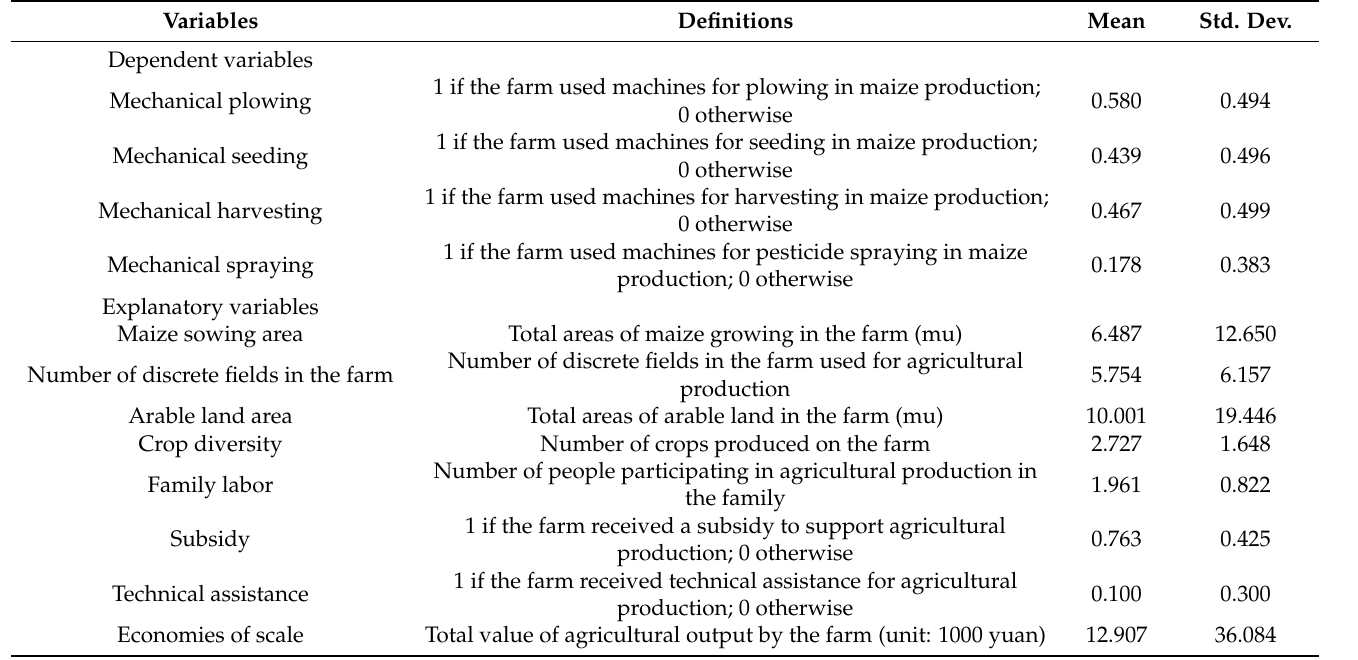
Table 2. Descriptive statistics of